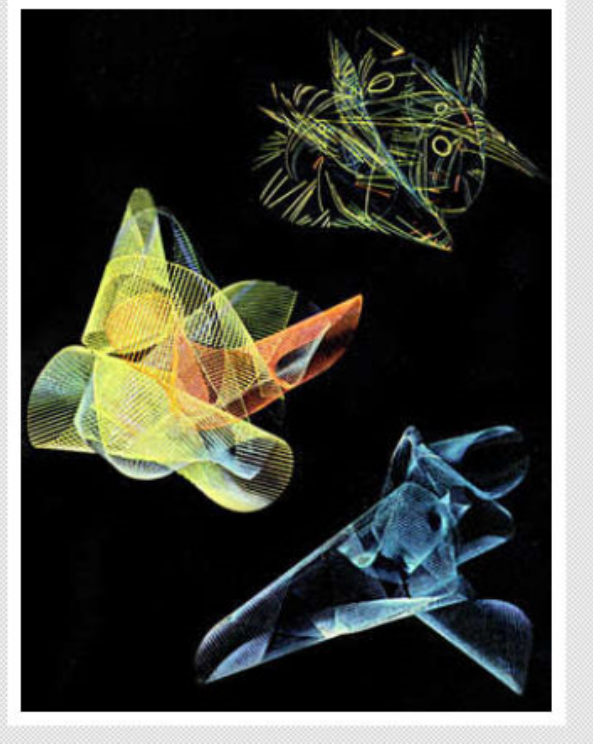
Figure 4. Robert Mallary, Luminous Mobiles , 1952. Image courtesy of estate of artist.